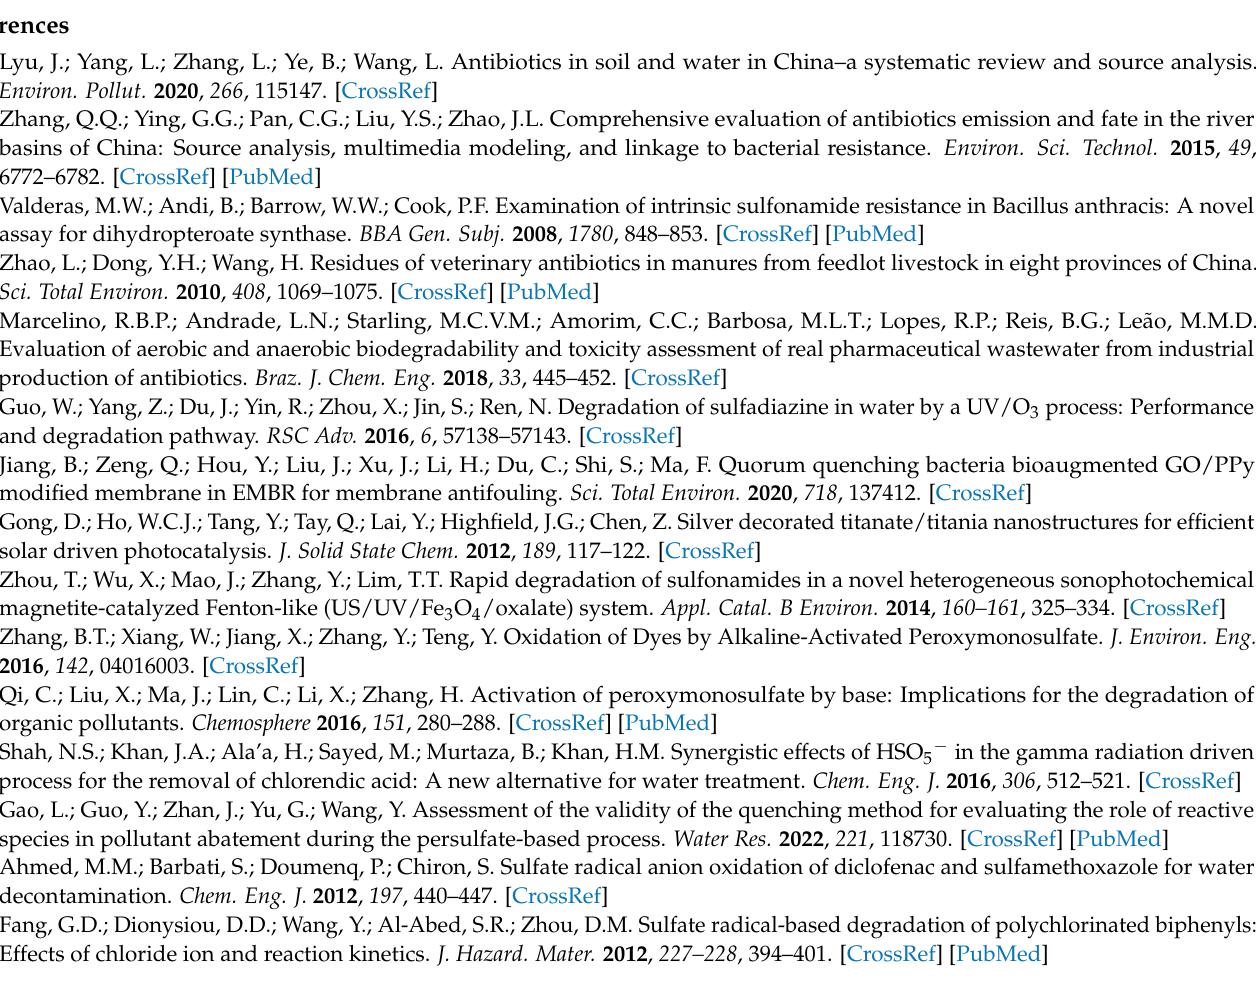
(b)-MBET aperture distribution image; Figure S2: XPS image of Fe-C-N(M) un-used (a) and used (b) degradation; Figure S3: the SMZ degradation pathways; Figure S4: (a)-Catalyst reuse experiment; (b)-Dissolution of Fe metal after repeated use of catalyst. Table S1: Determination parameters of pollutants by HPLC; Table S2: Fe-C, Fe-C-N(D), Fe-C-N(M) content distribution of each element (%); Table S3: Fe-C-N(D), Fe-C-N(M) content distribution of element (%); Table S4: Element content un-used and used degradation (%); Table S5: Table of SME